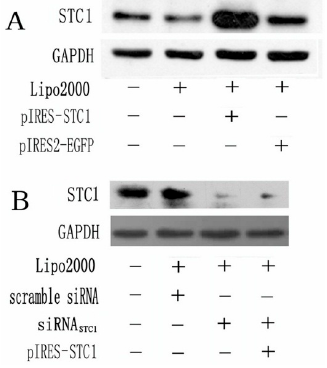
Figure 1. Detection of the expression of STC1 in Caco2 cells by Western blotting. ( A ) STC1 expression in Caco2 cells was detected 48 h post transfection of pIRES-STC1; ( B ) STC1 expression was detected 48 h post transfection of siRNA STC1 , or pIRES-STC1 + siRNA STC1 . All of the experiments were replicated for three times.